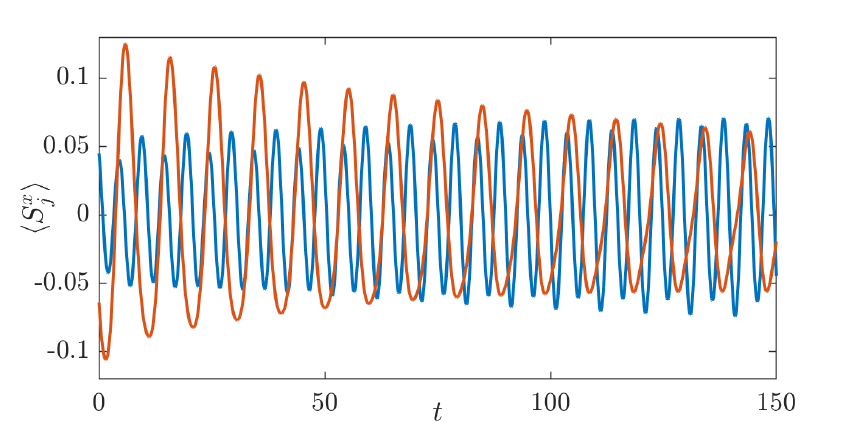
Figure 8: Evolution of S x observable on sites A (blue) and B (red) for the Spin-1, pure gain model. We have non-zero detuning and interaction, ∆ , ε (cid:54) = 0 and asym- (cid:54) = γ u metric driving, γ u . Initialising the system in a random state, we see that while A B persistent oscillations occur the two sites do not synchronize. This can be understood through the absence of generalised symmetry between sites A and B